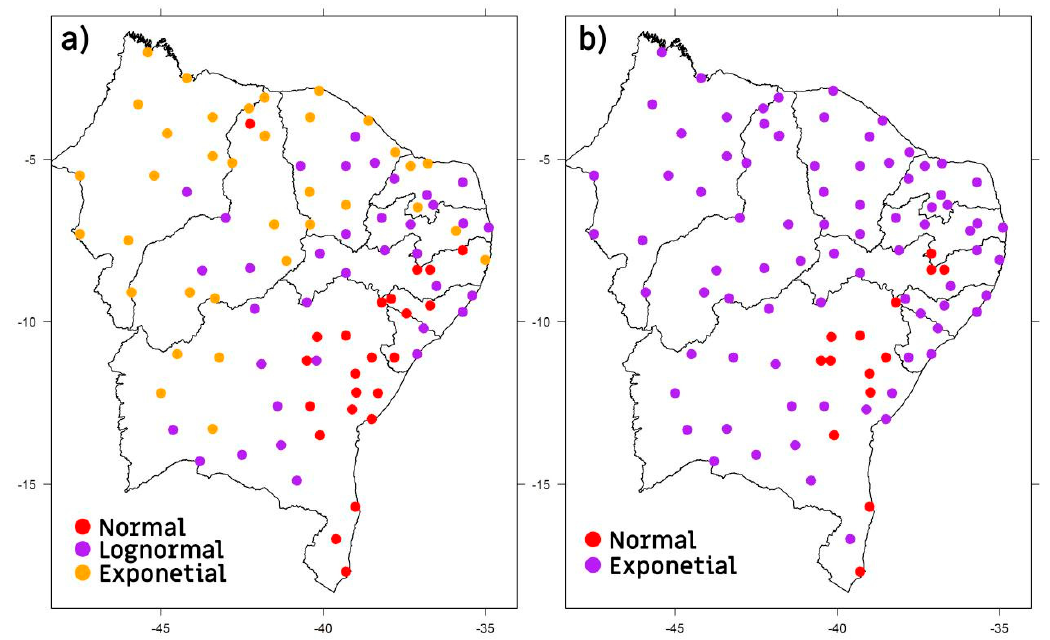
Figure 5. Probability distributions chosen according to the criterion of highest maximum log likelihood for series of drought ( a ) Severity and ( b ) Duration.